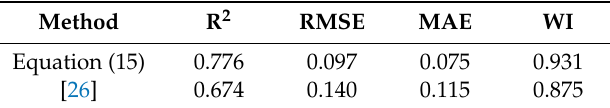
Table 4. Results of the statistical performance criteria for σ * X